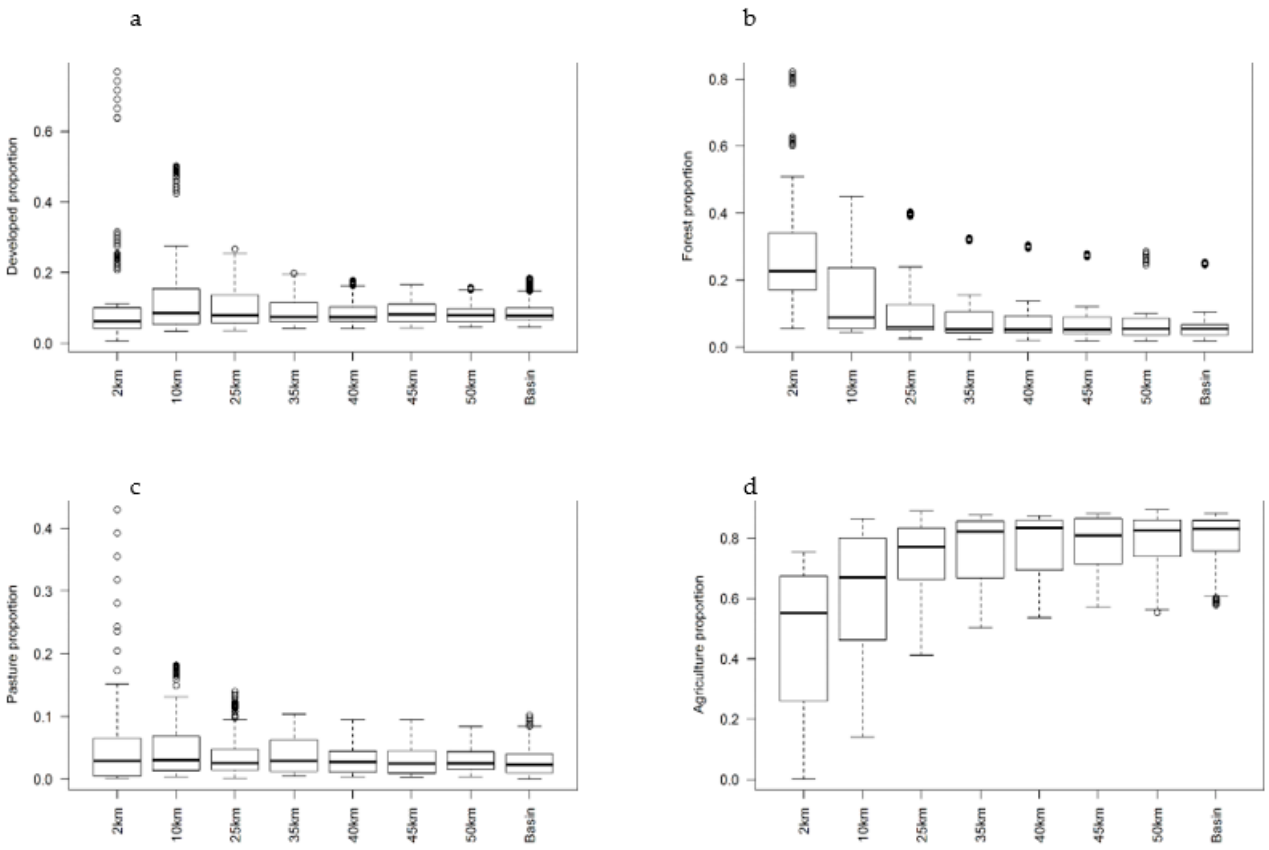
Figure 4. Boxplots of the percentages of the four land uses at different reach distances for study watersheds: ( a ) developed, ( b ) forest, ( c ) pasture, and ( d ) agriculture.